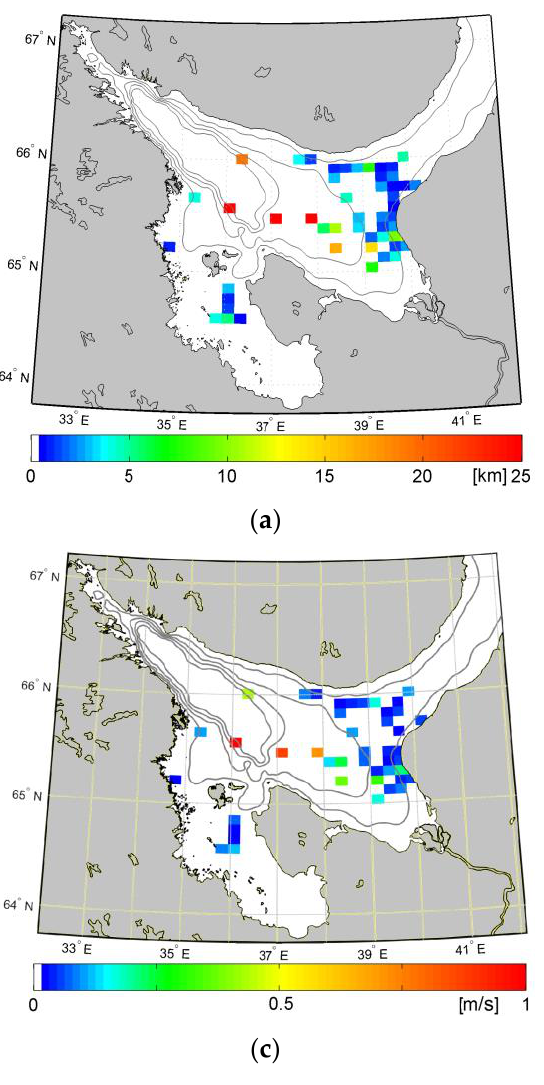
Figure 9. Spatial maps ( a , c ) and histogram ( b , d ) of interpacket distance ( a , b ) and propagation speed of ISWs ( c , d ).